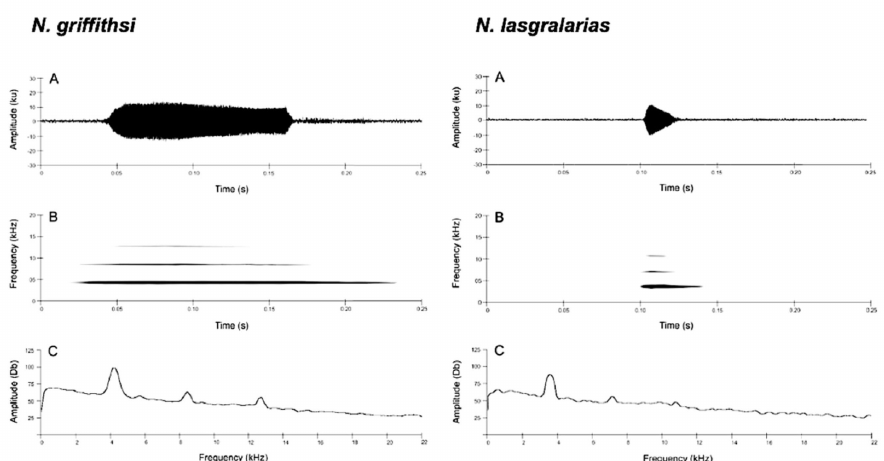
Figure 156. Advertisement call of Nymphargus gri ffi thisi and N . lasgralarias . ( A ) Oscillogram.